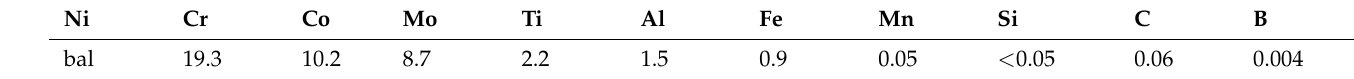
Table 1. Chemical composition of Haynes 282 (in wt.%) according to material